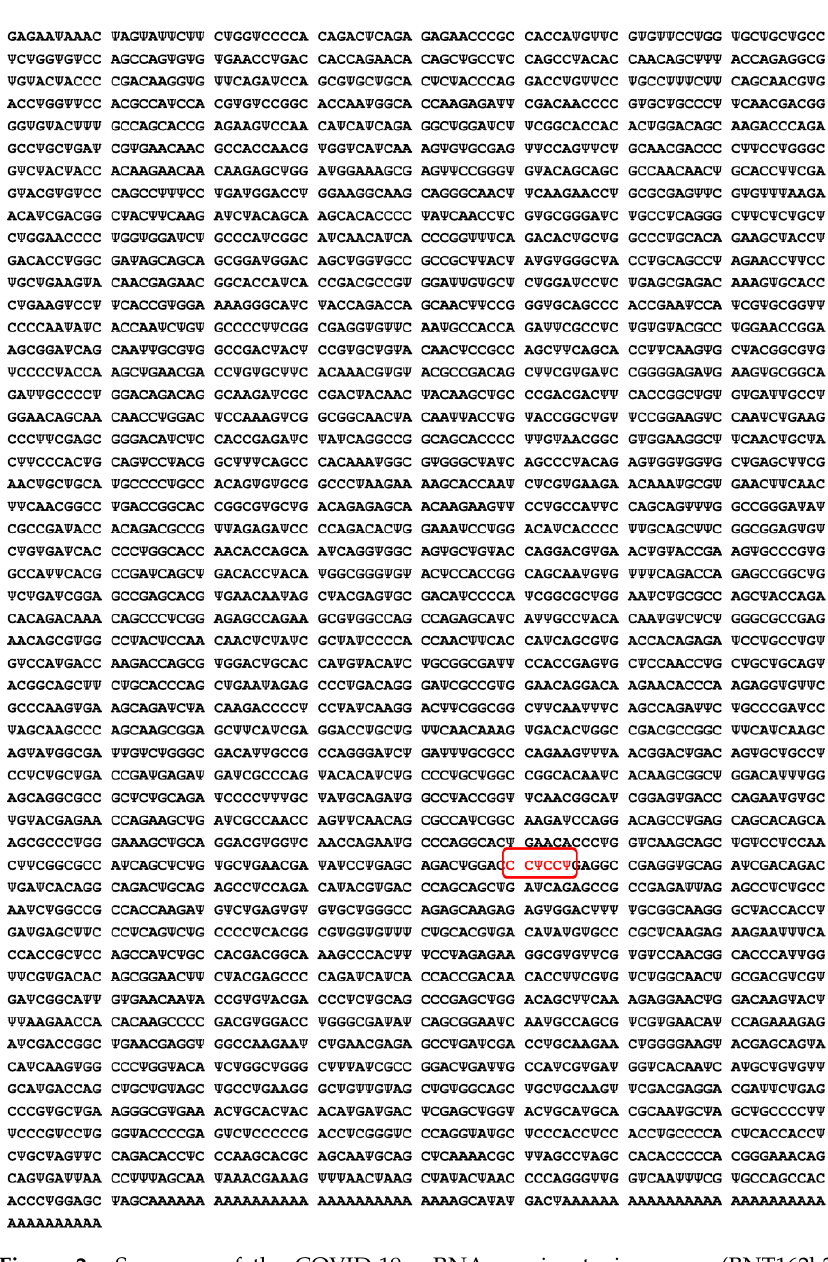
Figure 2. Sequence of the COVID-19 mRNA vaccine tozinameran (BNT162b2) from Pfizer/BioNTech ® , where Ψ indicates N1-methyl-3 (cid:48) -pseudouridine. This sequence has 4250 nucleotides: Adenine A, Cytosine C, Guanine G and Pseudo-uridine Ψ . An amino-acid modification of the Spike protein mRNA is indicated in red.